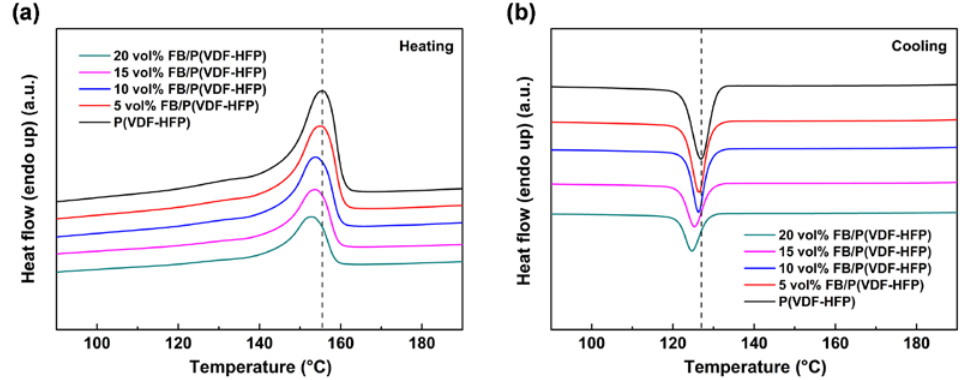
Figure 6. DSC of polymer and FB / P(VDF-HFP) composite ( a ) heating curves and ( b ) cooling curves.